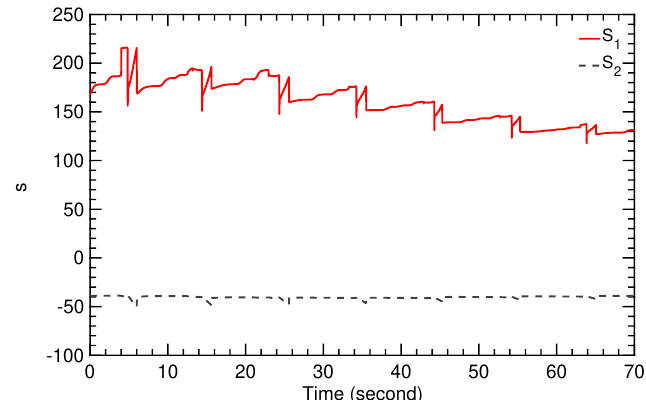
Figure 16. Time history of controller parameters s 1 and s 2 for flight condition